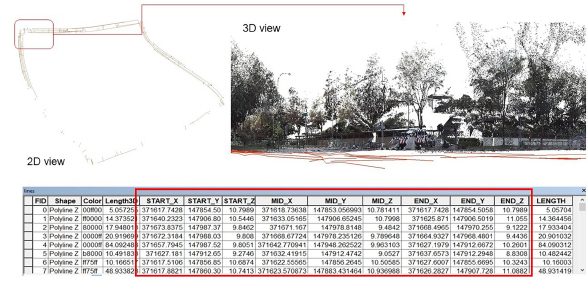
Figure 9. Results from data capture.